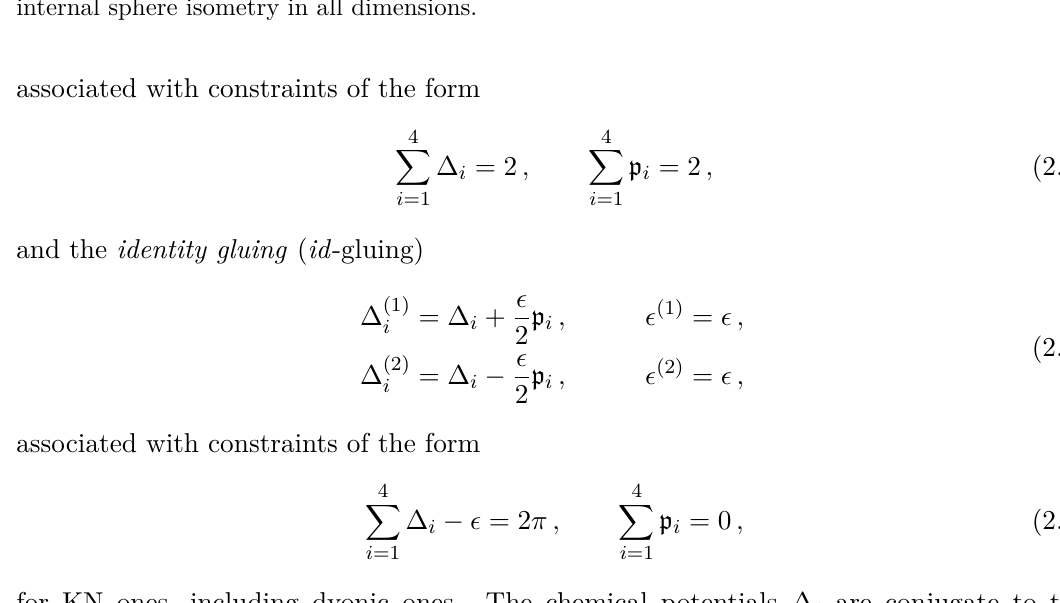
Table 1 . The structure of the block for the AdS backgrounds with maximal allowed supersymmetry in each dimension. AdS 6 × w S 4 is the background dual to the USp(2 N ) five-dimensional theory considered in this paper [26, 27]. The chemical potentials ∆ i are associated with the Cartan of the internal sphere isometry in all